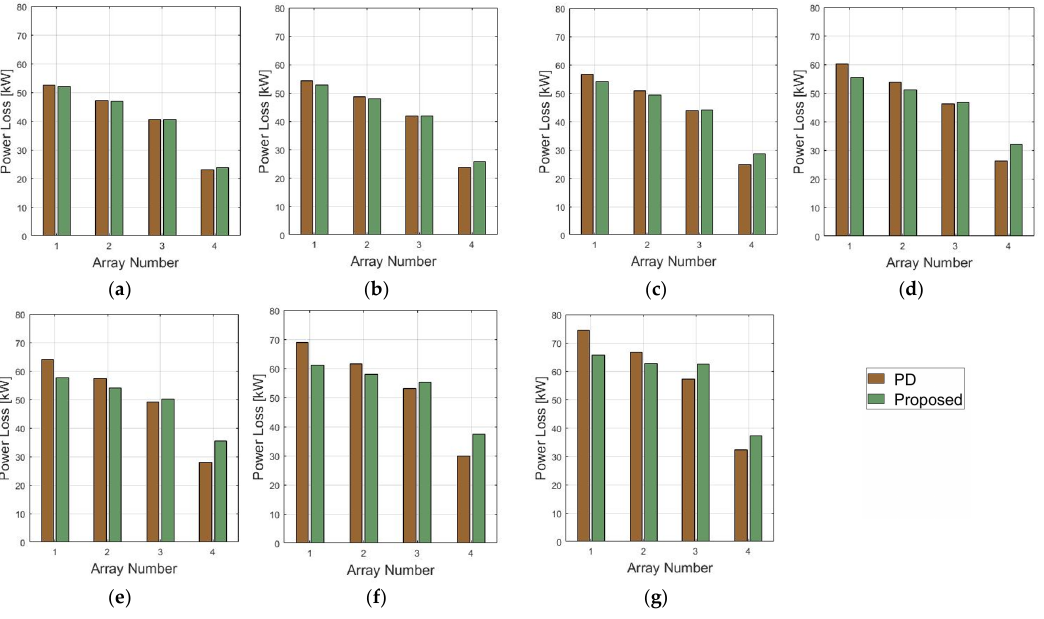
Figure 10. Power loss due to different reactive power dispatch signal: ( a ) Q pcc = 4 MVar; ( b ) Q pcc = 6 MVar; ( c ) Q pcc = 6 MVar; ( d ) Q pcc = 8 MVar; ( e ) Q pcc = 10 MVar; ( f ) Q pcc = 12 MVar; ( g ) Q pcc = 14